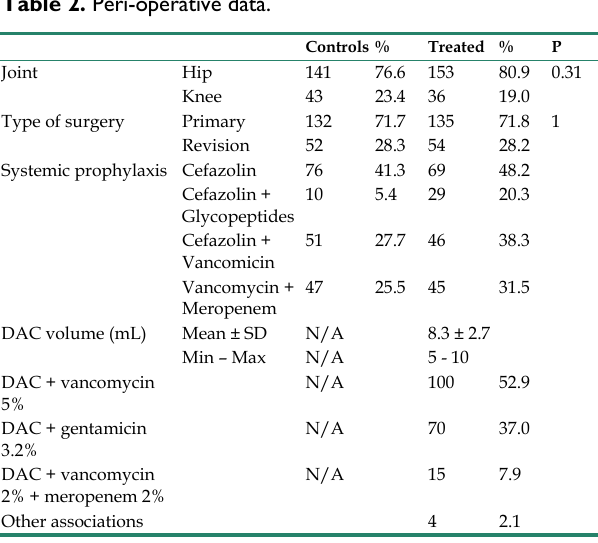
Table 2. Peri-operative